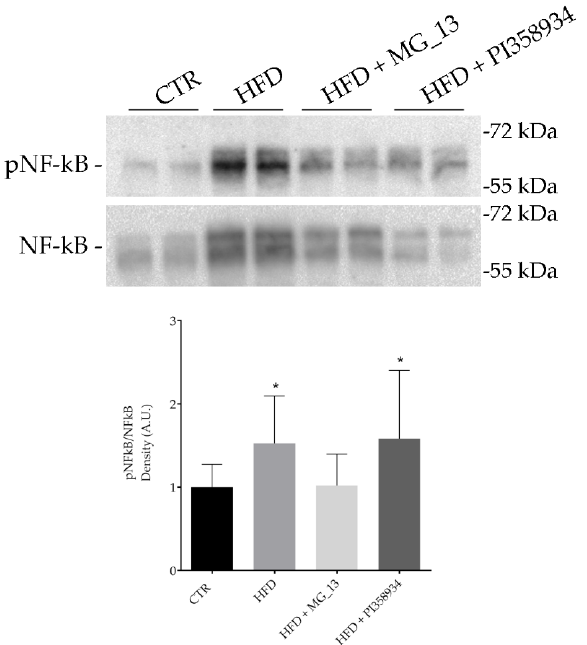
Figure 6. E ff ects of chickpea diets on NF-kB phosphorylation. Liver lysates were prepared as described in the Methods Section. An equal amount of proteins (30 µ g / lane) was separated by gel electrophoresis and immunoblotted for the evaluation of pNF-kB and total NF-kB levels. Densitometric analysis revealed that the HFD diet (HFD, n = 12) caused a significant increase in pNF-kB levels as compared with the mice fed with a normal diet (CTR, n = 12). The diet with HFD + MG_13 ( n = 12) prevented the HFD dependent increase of pNF-kB. Data are expressed as means ± S.D. and were analyzed by one-way ANOVA followed by Dunnett’s multiple comparisons test (* p < 0.05 vs. CTR).